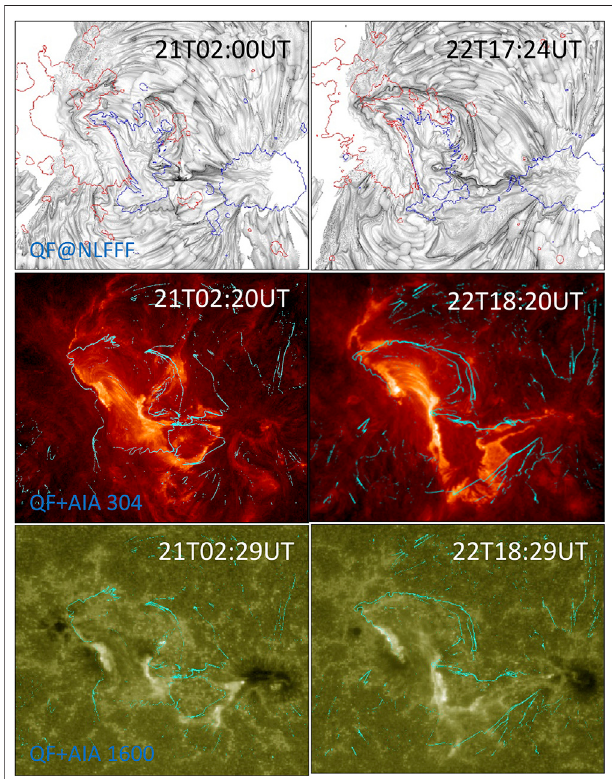
FIGURE 7 | Comparison of QSLs and fl are ribbons for the pre-eruptive magnetic structure of CME2 ( fi rst column) and CME3 (second column) in the AR 12371. First row: Inverse maps of Log( Q ) obtained at z (cid:1) 1.5 Mm . B z - contours at ± 120 G are overdrawn (red/blue curves). QSLs with large Q values are identi fi ed by intense black traces in strong fi eld region. All maps are scaled within 1 < Log( Q ) < 7. QSLs of large Q-values separate the sheared/ twisted core fi eld from the surrounding less sheared fi eld in the following bipolar region. Also higher Q-values in quiet regions are due to noisy transverse fi eld and have no relevance to the magnetic structure of interest. Secondandthirdrows: RelationbetweenQSLsand fl areribbons.Contours of Log( Q ) (cid:1) [5,6] (in cyan color) on AIA 304 Å (second row) and AIA 1600 Å (third row) snapshots taken at around the peak fl are time. The contours constitute two inverse-J sections, qualitatively outlining the inverse-S fl are